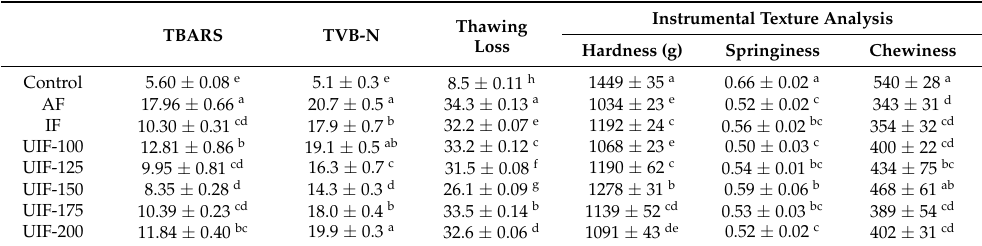
Table 1. Changes in thiobarbituric acid reactive substance (TBARS), total volatile base nitrogen (TVB-N), thawing loss and instrumental texture of the control adductor muscle of scallop (AMS) and 90-day frozen stored AMS with different treatments. Instrumental Texture Analysis TBARS TVB-N Thawing Loss Hardness (g)